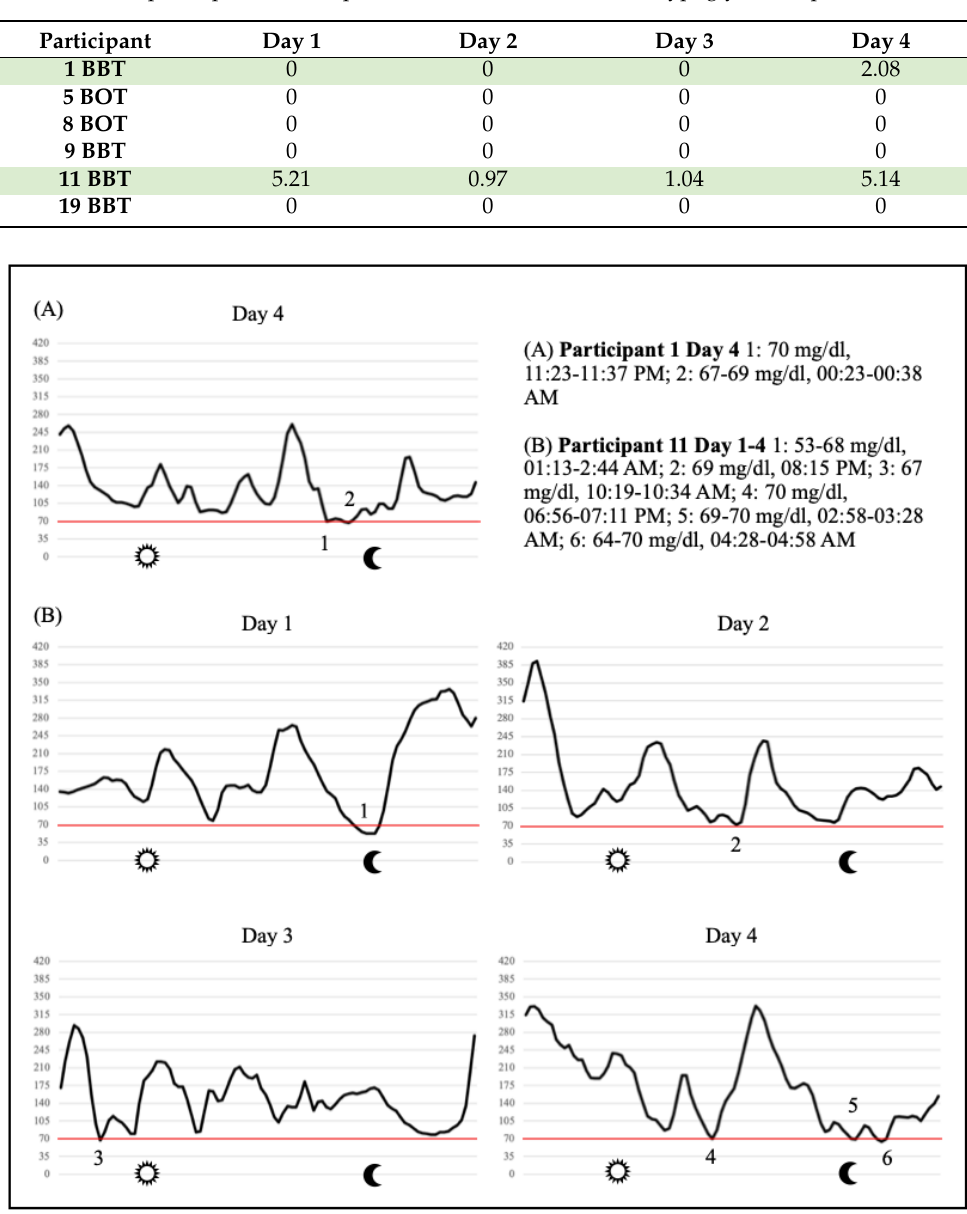
Figure 5. Glucose profiles from two participants with hypoglycemic events.